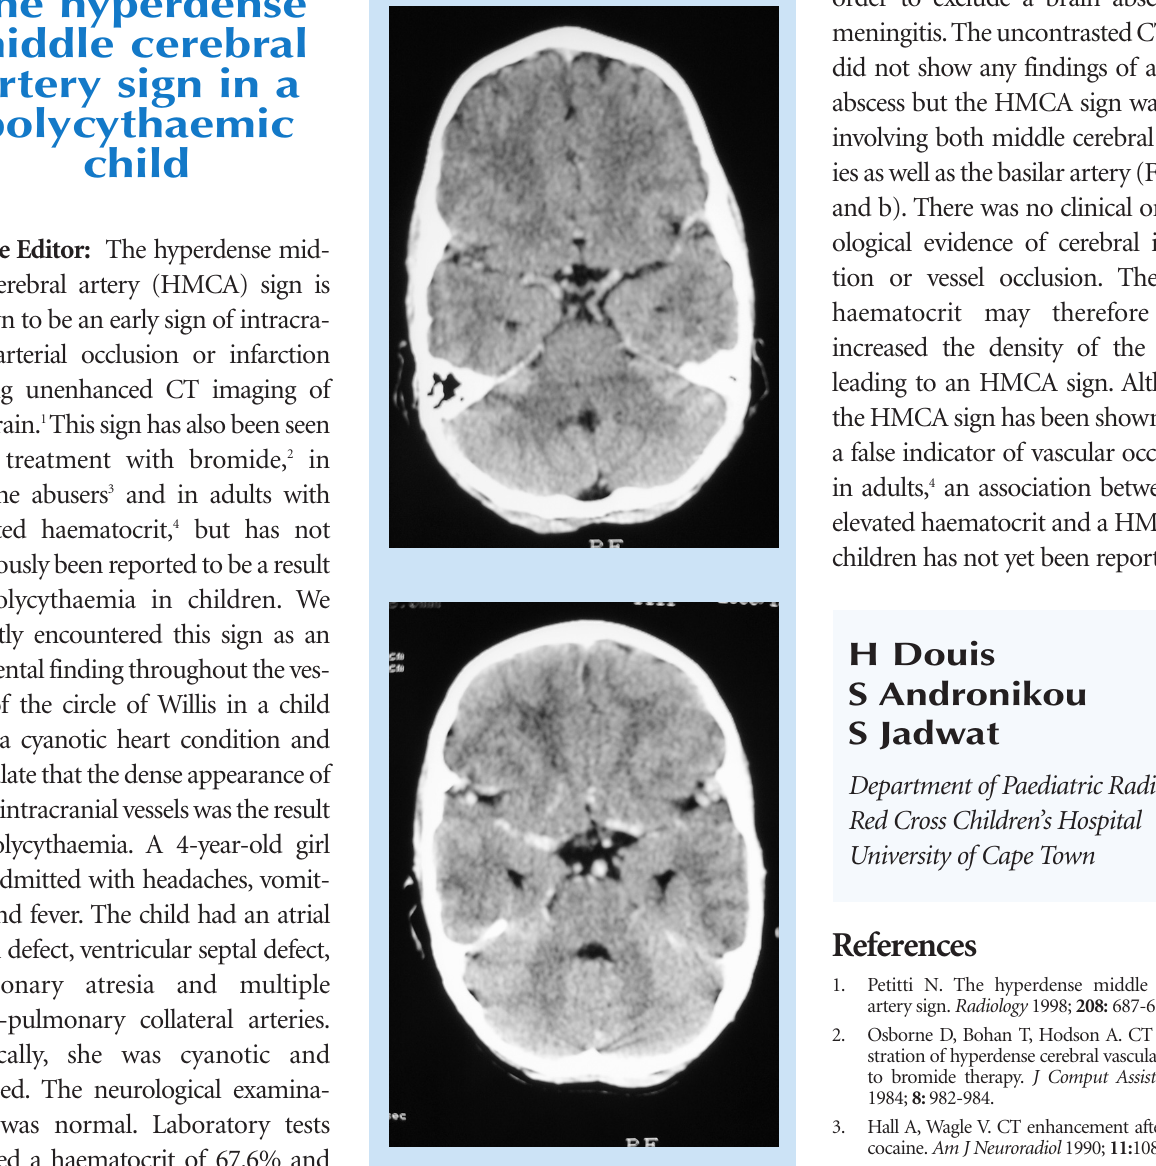
Figs 1 a and b. Sequential non-contrast CT slices in a 4-year-old girl show increased density of the arteries of the circle of Willis due to